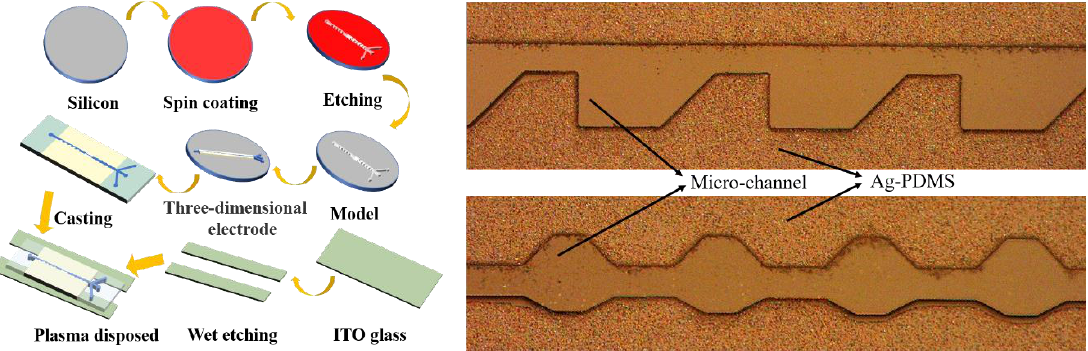
Figure 2. ( A ) Fabrication process of the microfluidic chip; ( B ) confocal microscopy image of the 3D electrodes.